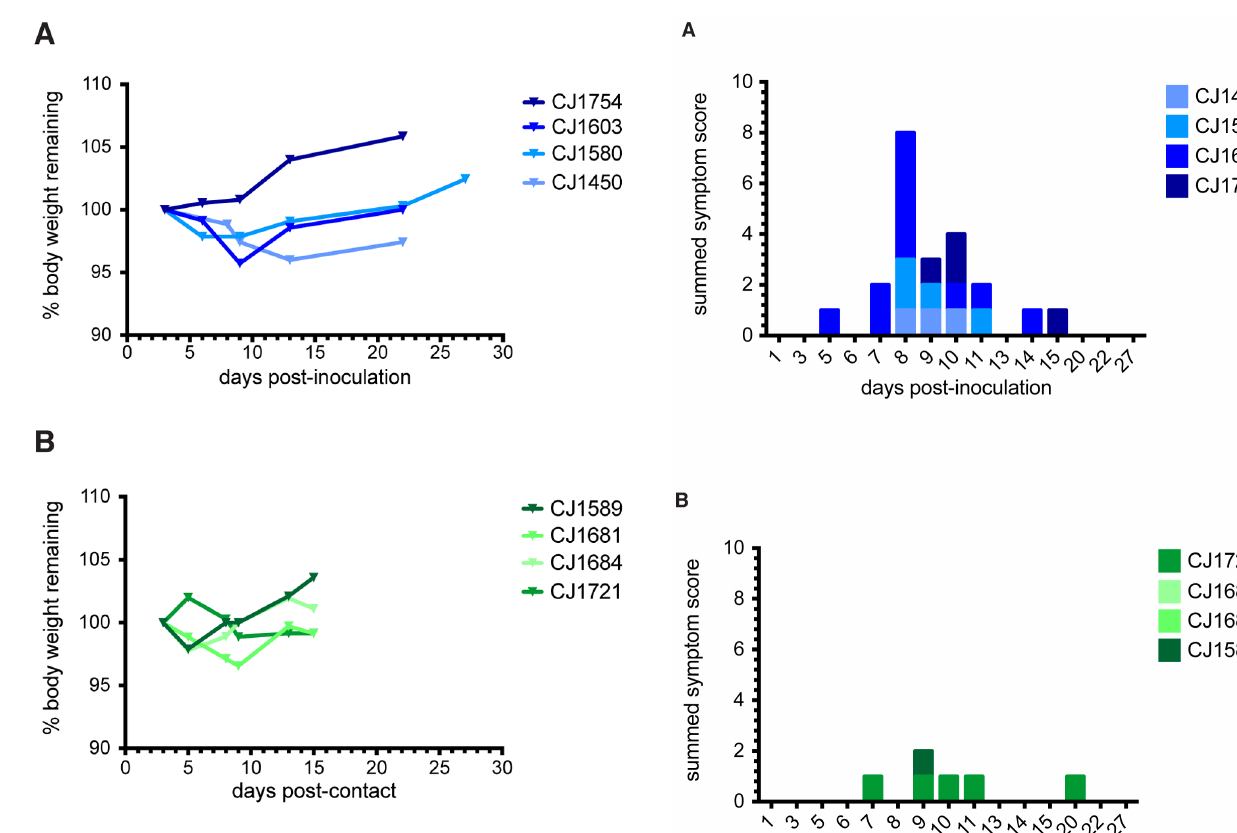
Figure 2. Body weight did not change during the study period in index (A) and contact (B) animals. No statistically significant difference in body weight lost was observed between infected and uninfected animals (unpaired t-test with Welch’s correction, p=0.8355).